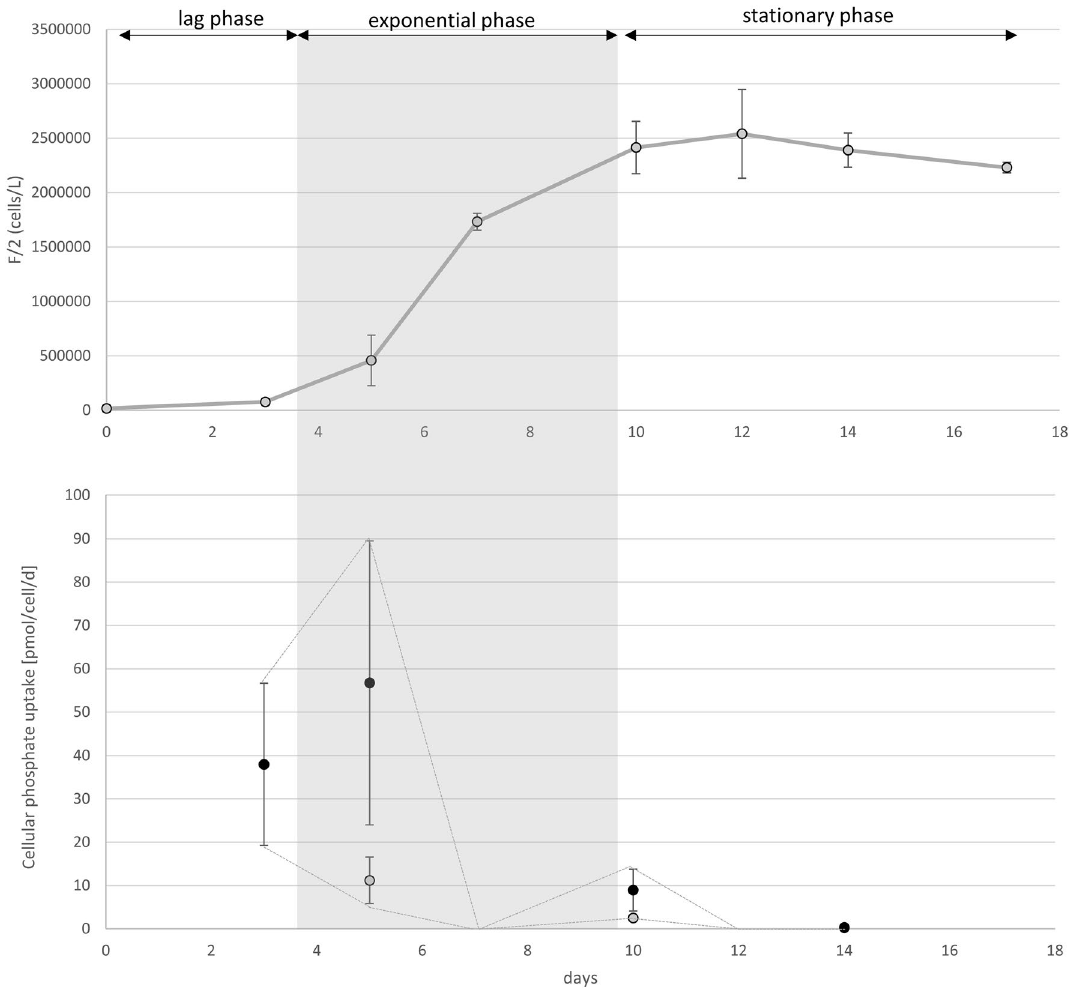
Figure 15. The dynamics of phosphate uptake rates for L. hargravesii throughout the experiment duration of batch cultures in F/2 medium. Dynamics of phosphate uptake rates throughout batch cultures of L. hargravesii in F/2 medium. ( a ) Average cell concentrations (and standard deviations) plotted over the duration of the batch culture.in days. The phases of the growth curve are indicated. ( b ) Cellular phosphate uptake rates calculated as phosphate uptake divided by cell numbers at the days of phosphate quantification (blue, or lower values) and divided by the cell numbers at the day of the measurement before (orange, or higher values). The dashed line indicates lower and upper borders between the two calculation methods. The true uptake rate must be between the two borders. Note the steep drop of phosphate uptake rates during exponential